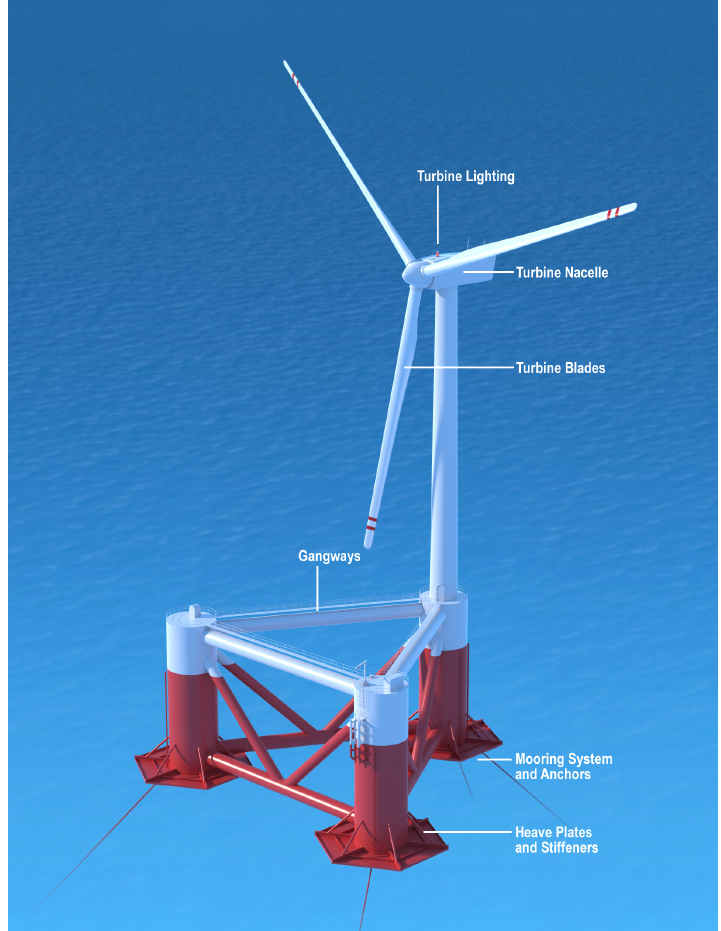
Figure 1. A floating offshore wind turbine showing heave plates attached to the structural columns [2]. Attributed to Untrakdrover/CC BY-SA